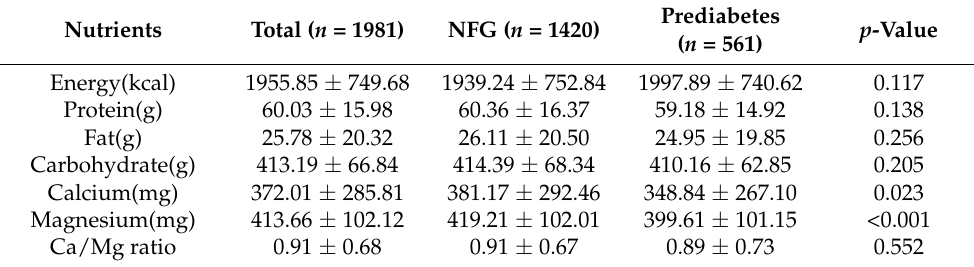
Table 3. Mean daily nutrient intake (energy-adjusted) (Mean ±